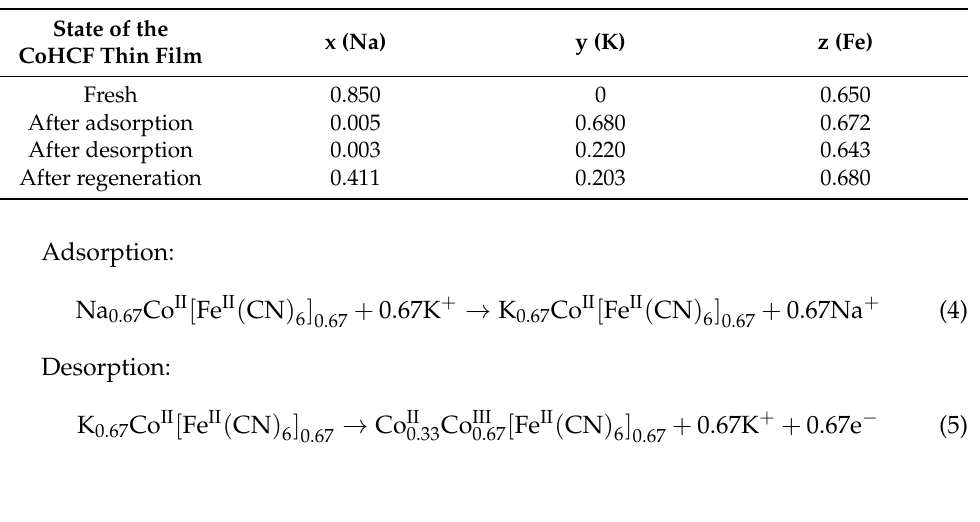
Table 4. Change of chemical composition of CoHCF thin film in the first adsorption-desorption- regeneration cycle at fresh state, after adsorption, desorption, and regeneration, the formula of CoHCF denoted as Na x K y Co[Fe(CN) 6 ] z . State of the CoHCF Thin Film